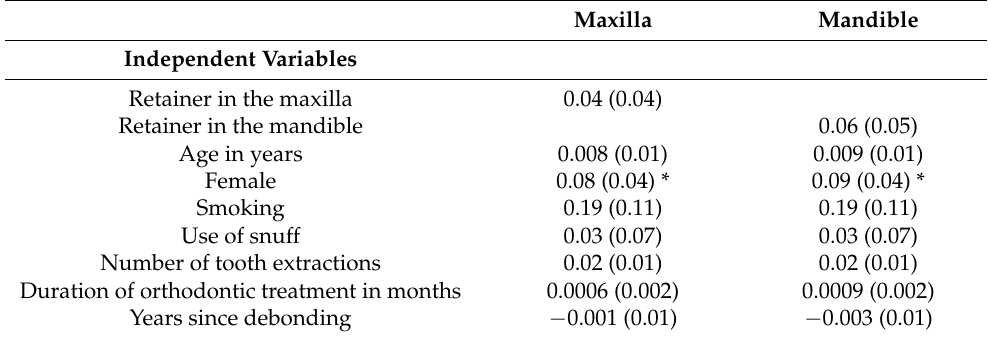
Table 7. Predictors of patient-reported lengthening of teeth as an indicator of gingival recession.